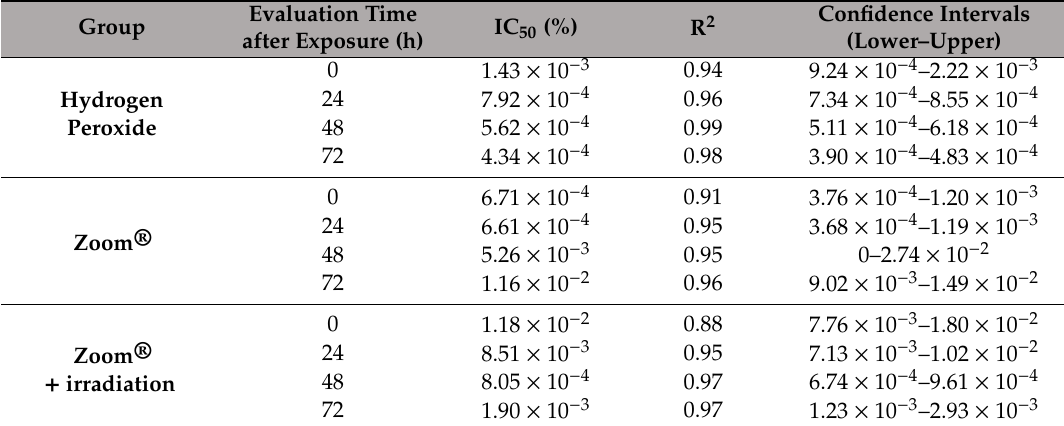
Table 1. Half-maximal inhibitory concentration (IC 50 ) of fibroblast cells after exposure to the three conditions.